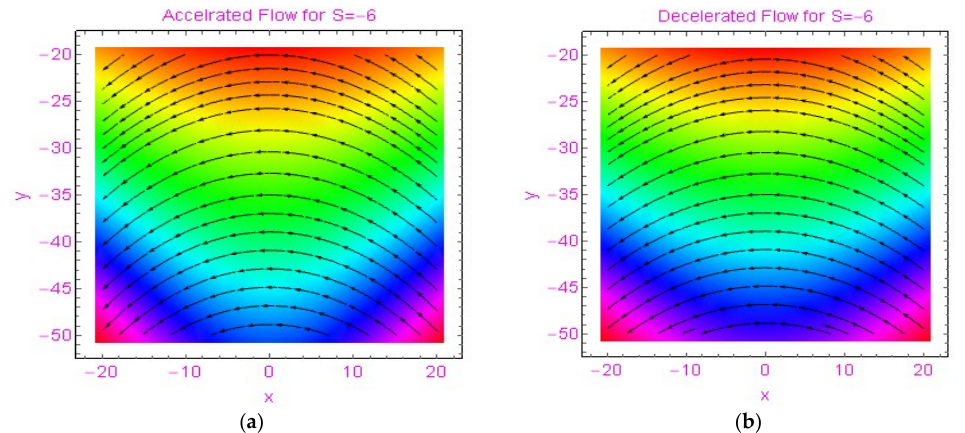
Figure 6. Streamlines behavior for ( a ) accelerated and ( b ) decelerated flow situations when S = 6.